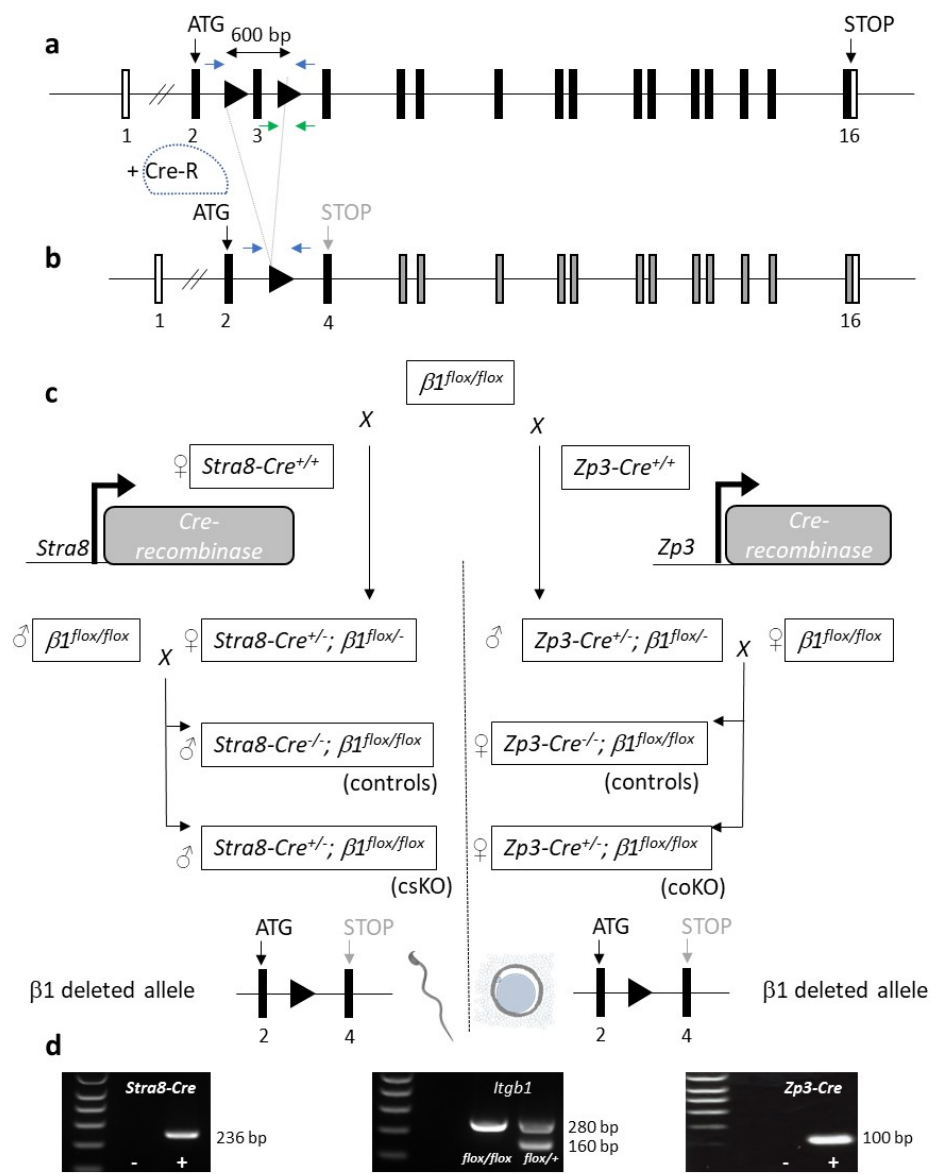
Figure 1. ( a , b ) Schematic representation of the Itgb1 floxed allele and excised allele respectively. ( c ) Mating using Itgb1 flox/flox with Stra8-Cre +/+ females or Zp3-Cre +/+ males to obtain double heterozygous Stra8-Cre +/ − Itgb1 flox/- or Zp3-Cre +/ − Itgb1 flox/- that we mated with Itgb1 flox/flox males or females respectively. Thanks to these crosses, the males of interest ( Stra8-Cre +/ − Itgb1 flox/flo , csKO) and their controls ( Cre − / − Itgb1 flox/flox ) (left) and the females of interest ( Zp3-Cre +/ − Itgb1 flox/flox , coKO) and their controls ( Zp3-Cre − / − Itgb1 flox/flox ) (right) were obtained. ( d ) The three gels show the presence of Cre whether it is under the control of the Stra8 or Zp3 promoters and the presence of the LoxP sites on one or two alleles of Itgb1 gene.